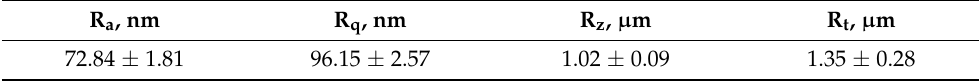
Table 2. Profile roughness parameters of used counter-body in tribological tests.